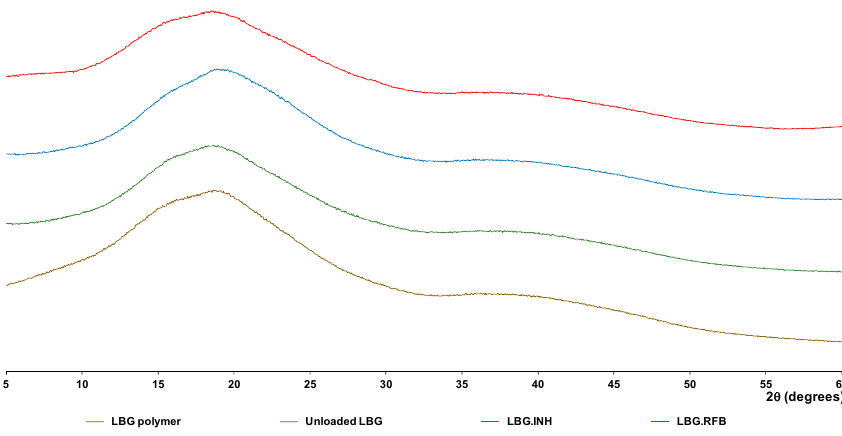
Figure 3. XRD diffractograms of locust bean gum (LBG) raw material and spray-dried formulations: LBG raw material ( brown line), unloaded LBG microparticles ( green line), LBG:INH 10:1 microparticles ( blue line), LBG:RFB 10:1 microparticles ( red line); INH: isoniazid; LBG: locust bean gum; RFB: rifabutin.